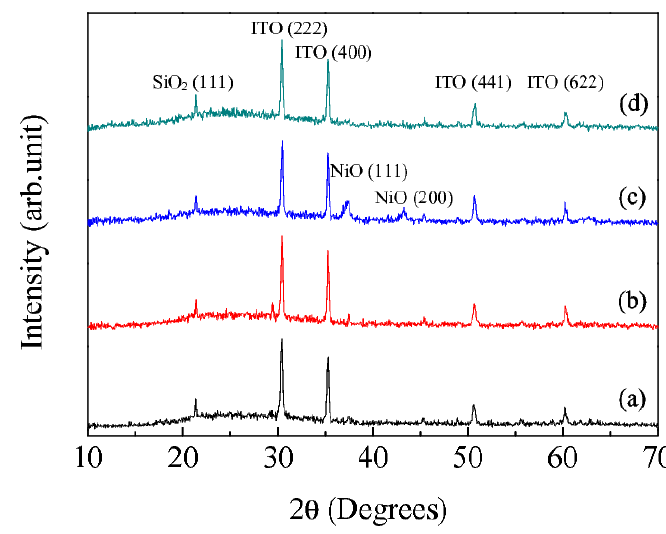
Figure 2. X-ray patterns of the composite electrodes: ( a ) ITO/glass substrate; ( b ) MCMB/ITO/glass; ( c ) NiO/MCMB/ITO/glass; ( d ) WO 3 /MCMB/ITO/glass.